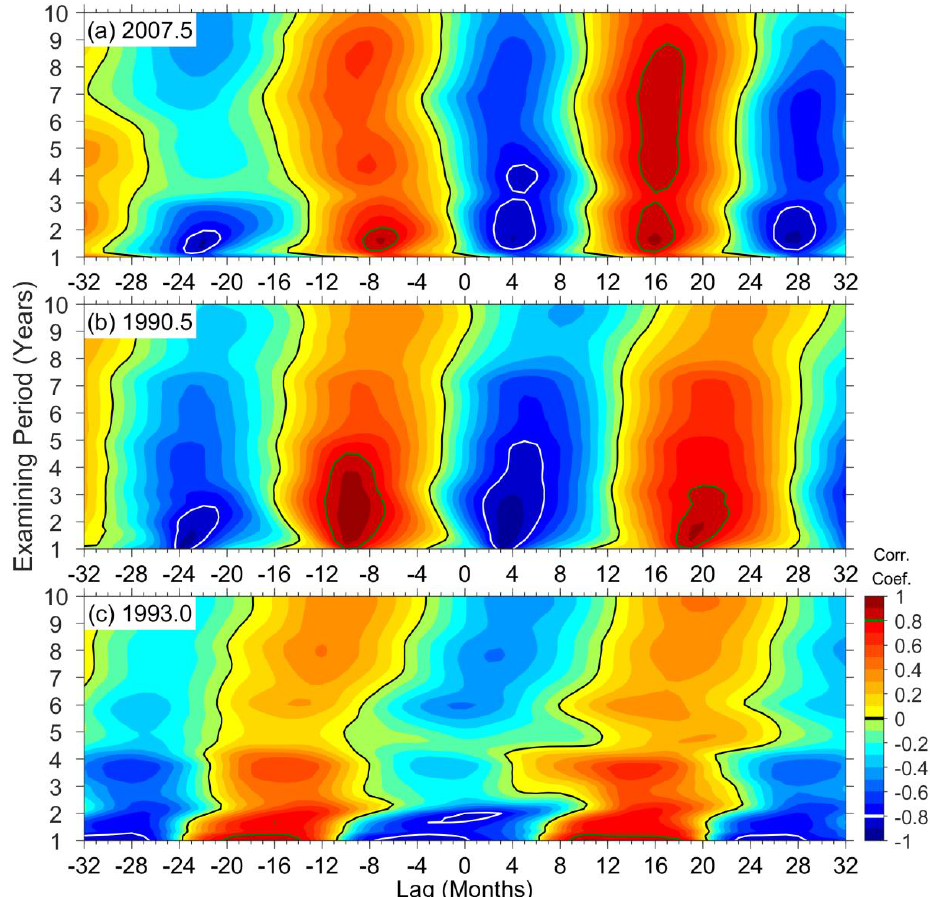
Figure 11. The correlation coefficients between the lower stratospheric and lower mesospheric E P–12 , as functions of lag time and examining period centered over three epochs of ( a ) 2007.5, ( b ) 1990.5, and ( c ) 1993.0,